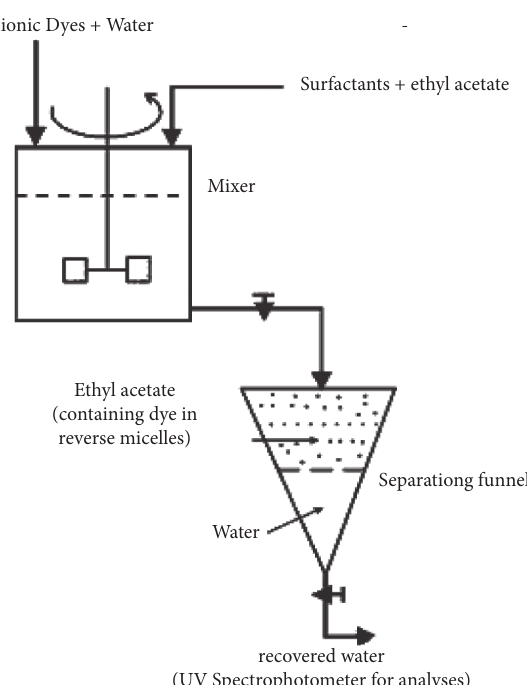
Figure 3: Experimental setup schematic diagram for the removal of dye from the aqueous phase [24].